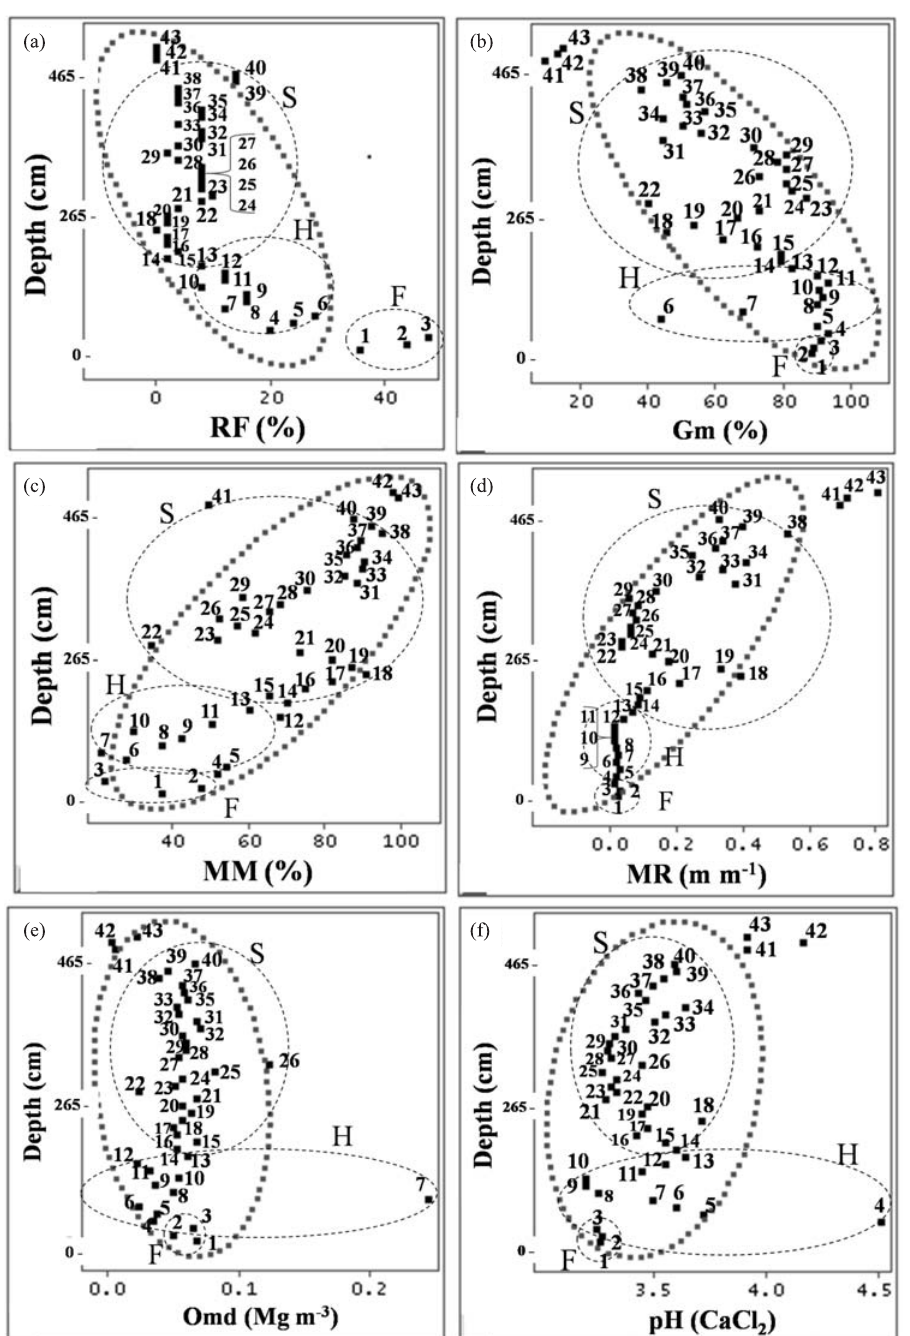
Figure 4. Depth distribution of properties of a profile of the peatland from Pau-de-Fruta SPA. RF: Rubbed fibers. Gm: Gravimetric humidity. MM: Mineral material. MR: Minimal residue. Omd: Organic matter density. pH: in CaCl . F: Fibric. H: Hemic. S: 2